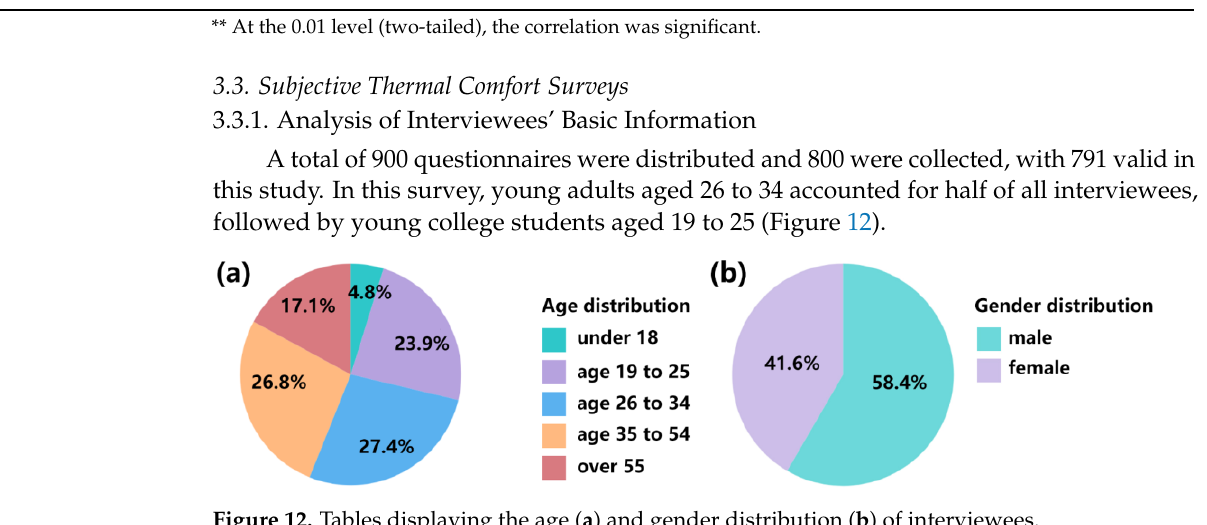
Figure 12. Tables displaying the age ( a ) and gender distribution ( b ) of interviewees. People over the age of 55 made up 17.1% of the population. Observations revealed that 77.0% of interviewees wore short sleeves (or long skirts), 12.7% wore long sleeves, 7.6% wore thin coats, and 2.7% wore vests. At the same time, the research team